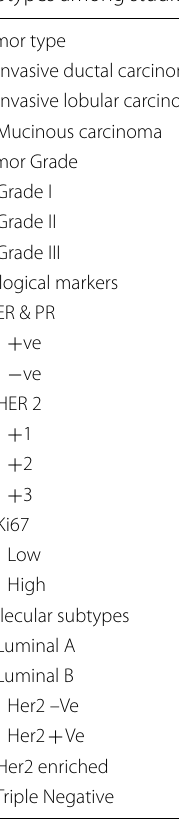
Table 1 Tumor type, grade, biological markers and molecular subtypes among studied